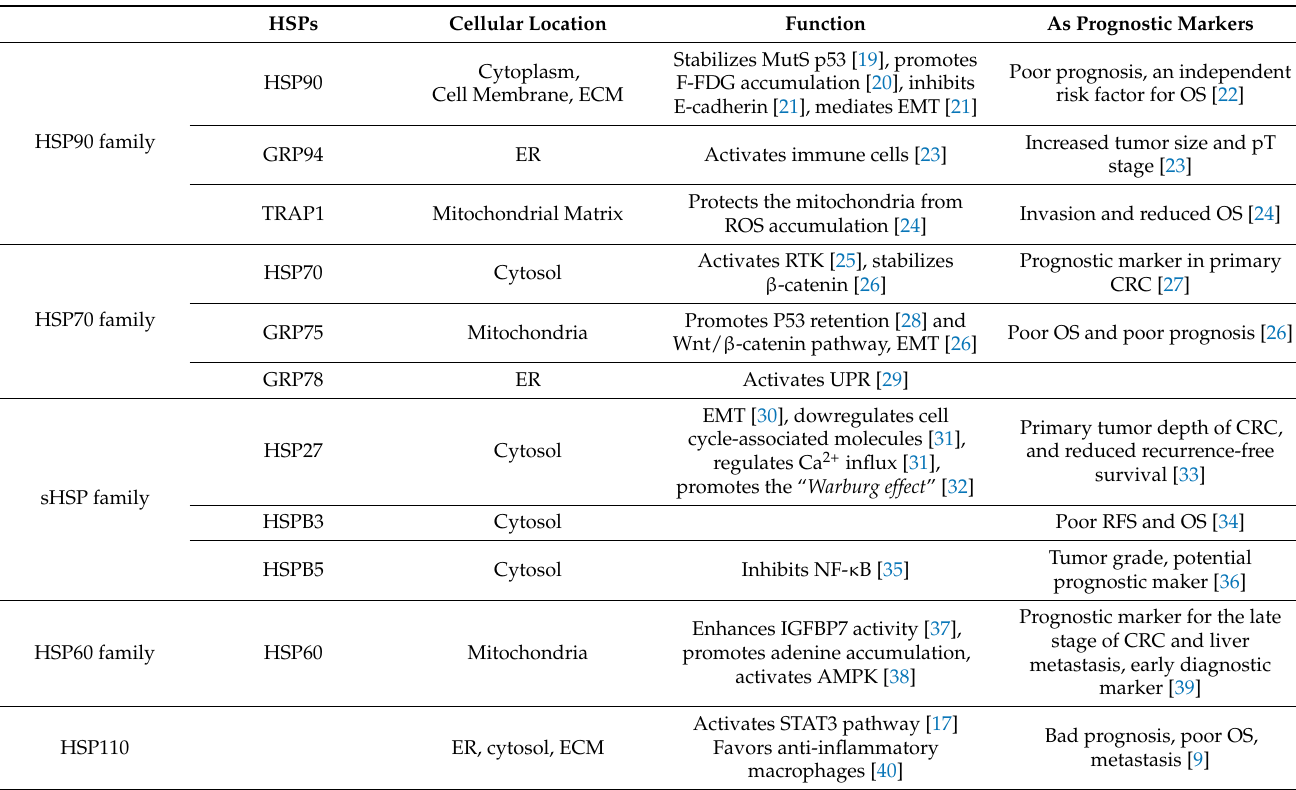
Table 1. HSPs localization, function, and their role prognostic markers in CRC. ER: Endoplasmic reticulum, ECM: Extracel- luler matrix, F-FDG:Fluorodeoxyglucose (18F), EMT: Epithelial mesenchymal transition, OS: Overall survival, ROS: Reactive oxygen species, pT: post-therapy, RTK: Receptor tyrosine kinase, UPR: Unfolded protein response, RFS: relapse-free survival, NF- κ B: Nuclear factor kappa B, IGFBP7: Insulin-like growth factor binding protein 7, AMPK: AMP-activated protein kinase, STAT3: Signal transducers and activation of transcription